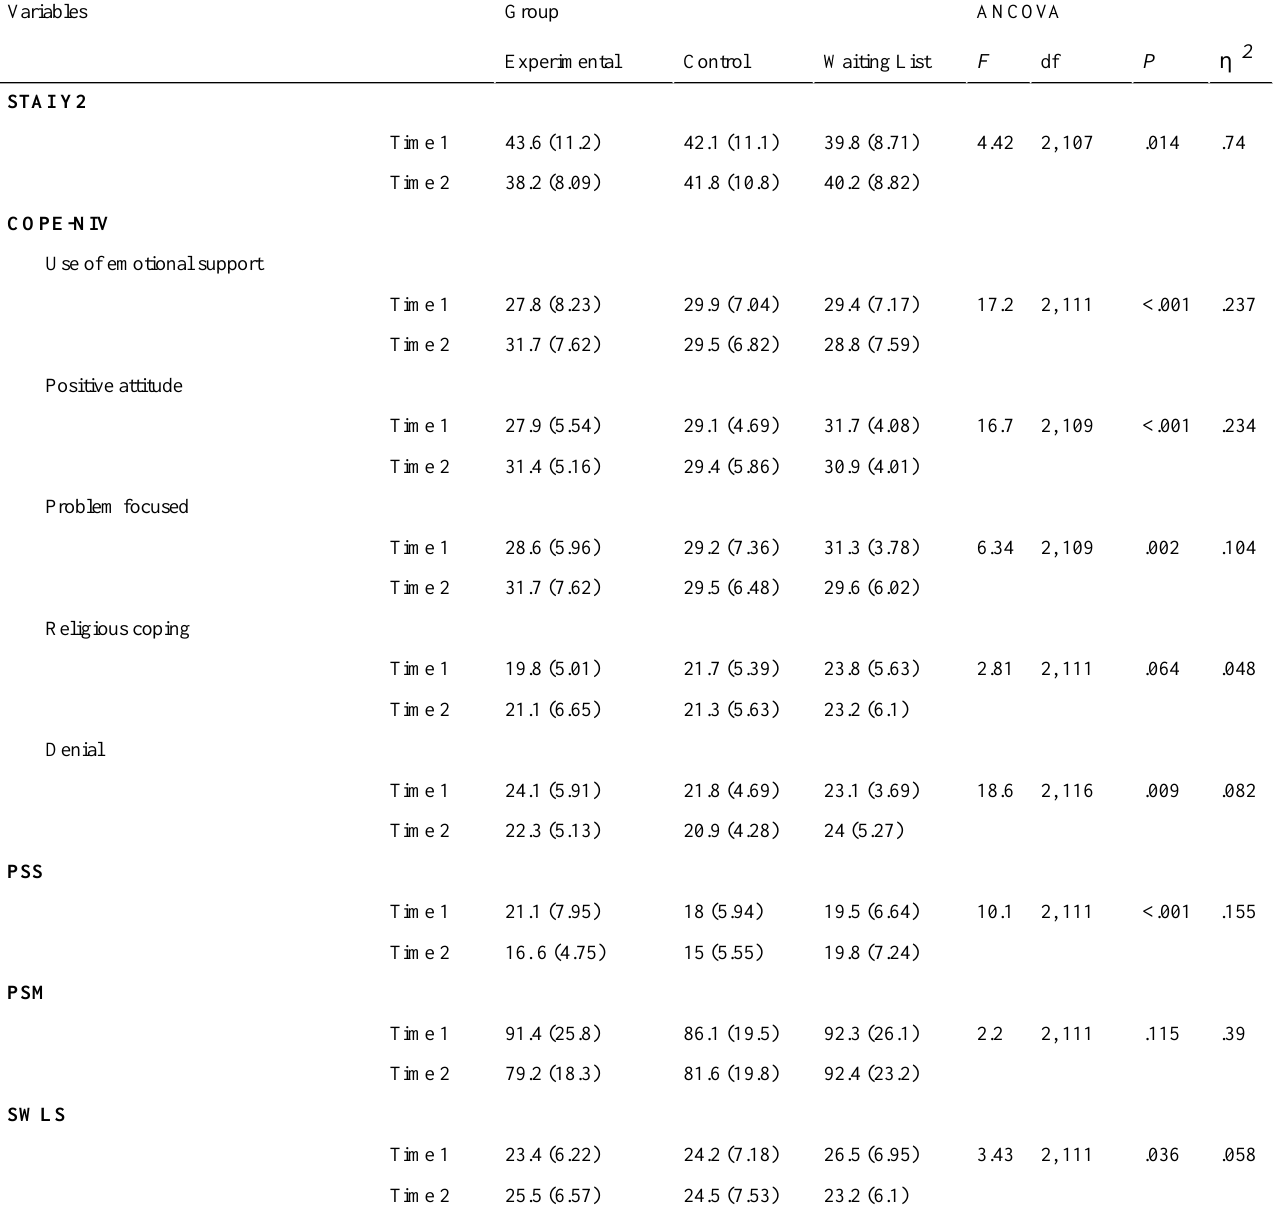
Table 3. ANCOVA results.